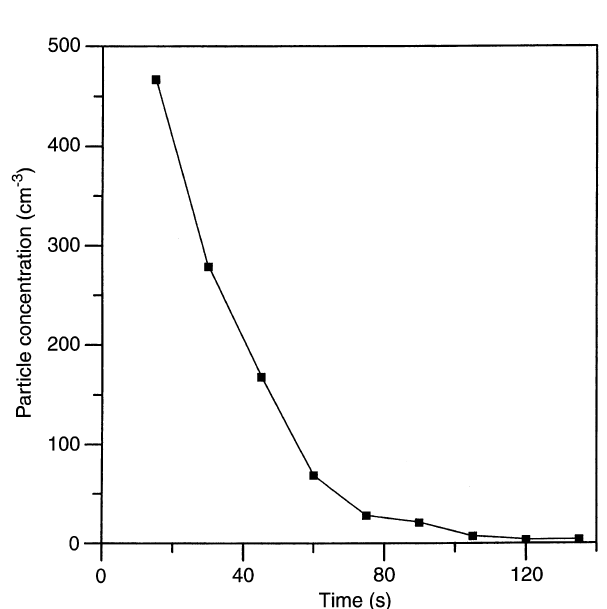
Fig. 8. Ice crystal concentration with time for a second cloud